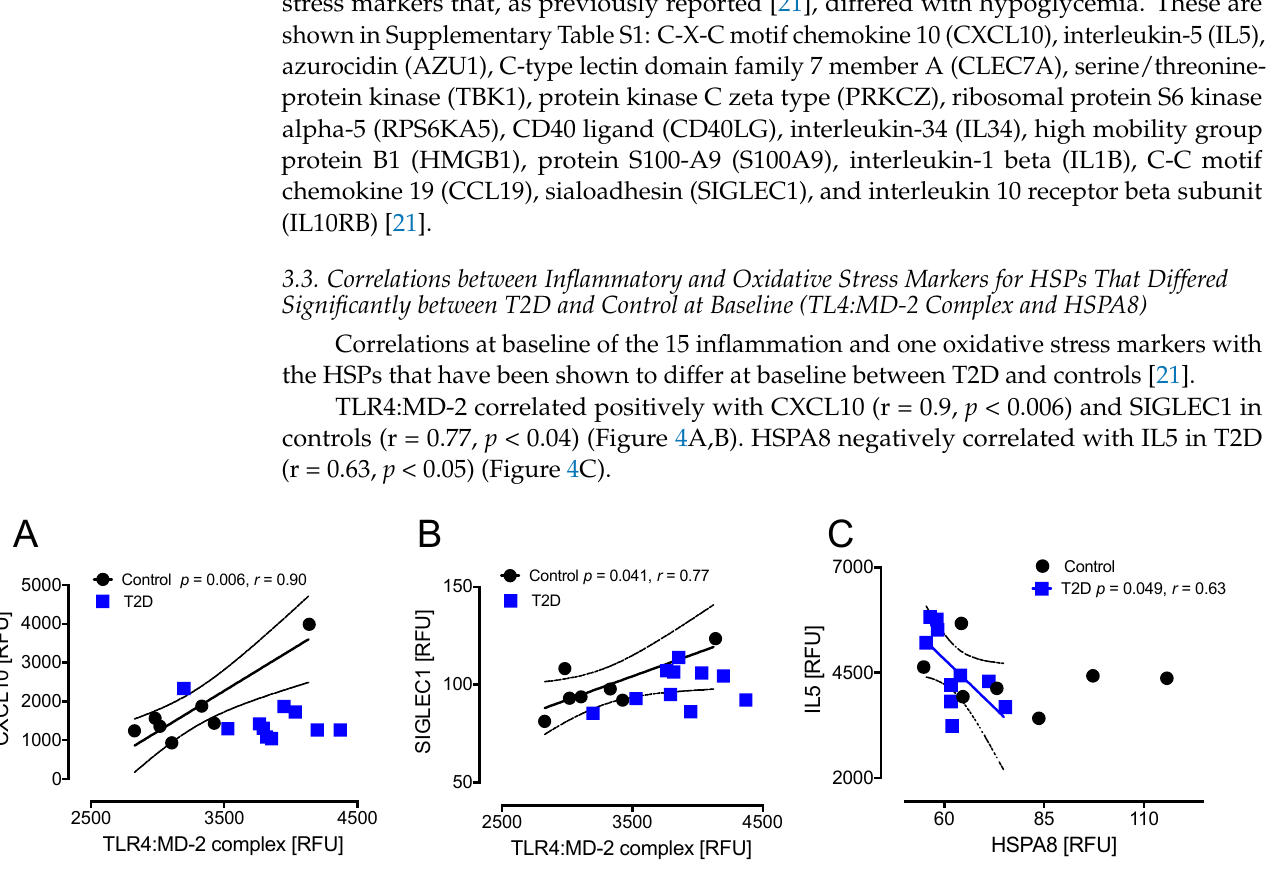
Figure 4. Correlations of HSPs that differed at baseline between T2D and control subjects with inflammatory proteins. At baseline, TLR4:MD-2 complex showed a positive correlation with CXCL10 ( A ) and SIGLEC1 ( B ) in control subjects. HSPA8 showed a negative correlation with IL5 ( C ) in T2D subjects. TLR4:MD-2 complex, toll-like receptor 4 in complex with MD-2; HSPA8, heat shock cognate 71 kDa protein; IL5, interleukin 5; RFU, relative fluorescent